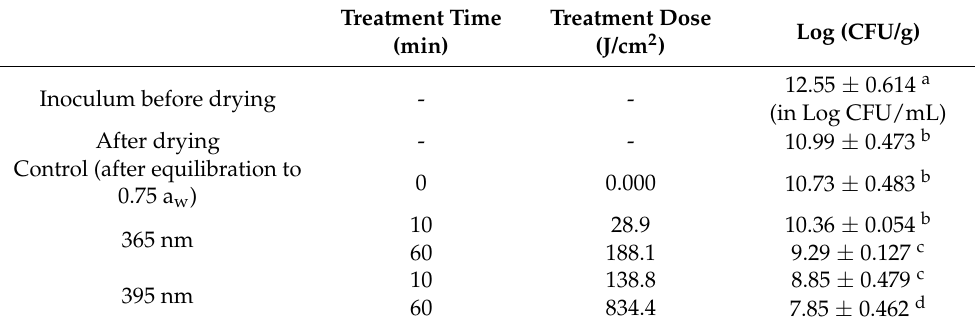
Table 1. Effect of 365 and 395 nm LED treatment on the survival of S. Typhimurium ATCC13311 cells, dried and equilibrated to 0.75 a w . Treatments with the 365 and 395 nm light pulses of low-a w S. Typhimurium cells were performed for 10 and 60 min corresponding to treatment doses of 28.9 and 188.1 J/cm 2 for 365 nm and 138.8 and 834.4 J/cm 2 for 395 nm, respectively, at 60% power level and at 4 cm from the LED heads. Treatment